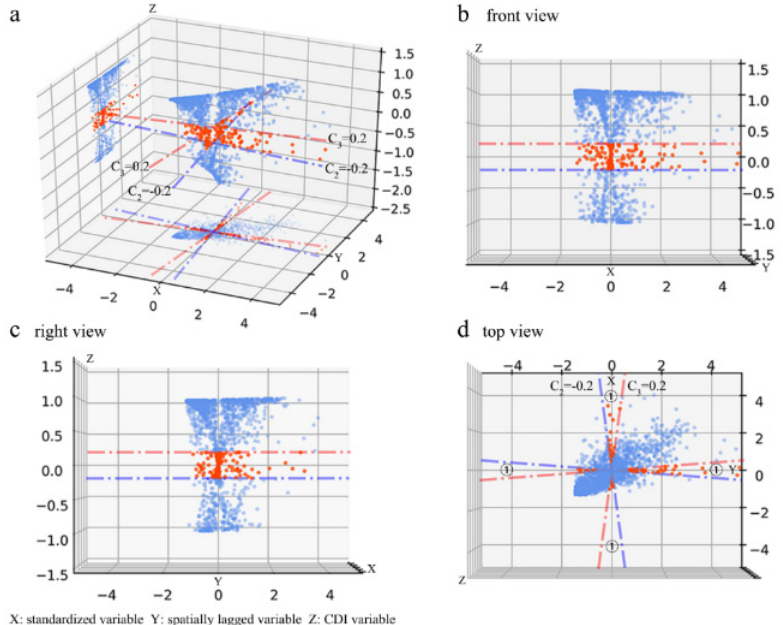
Figure 6. A visual representative method combining the Moran scatterplot and CDI. ( a ) Overview; ( b ) Front view; ( c ) Right view; ( d ) Top view. “ ① ”—Moran scatterplot.